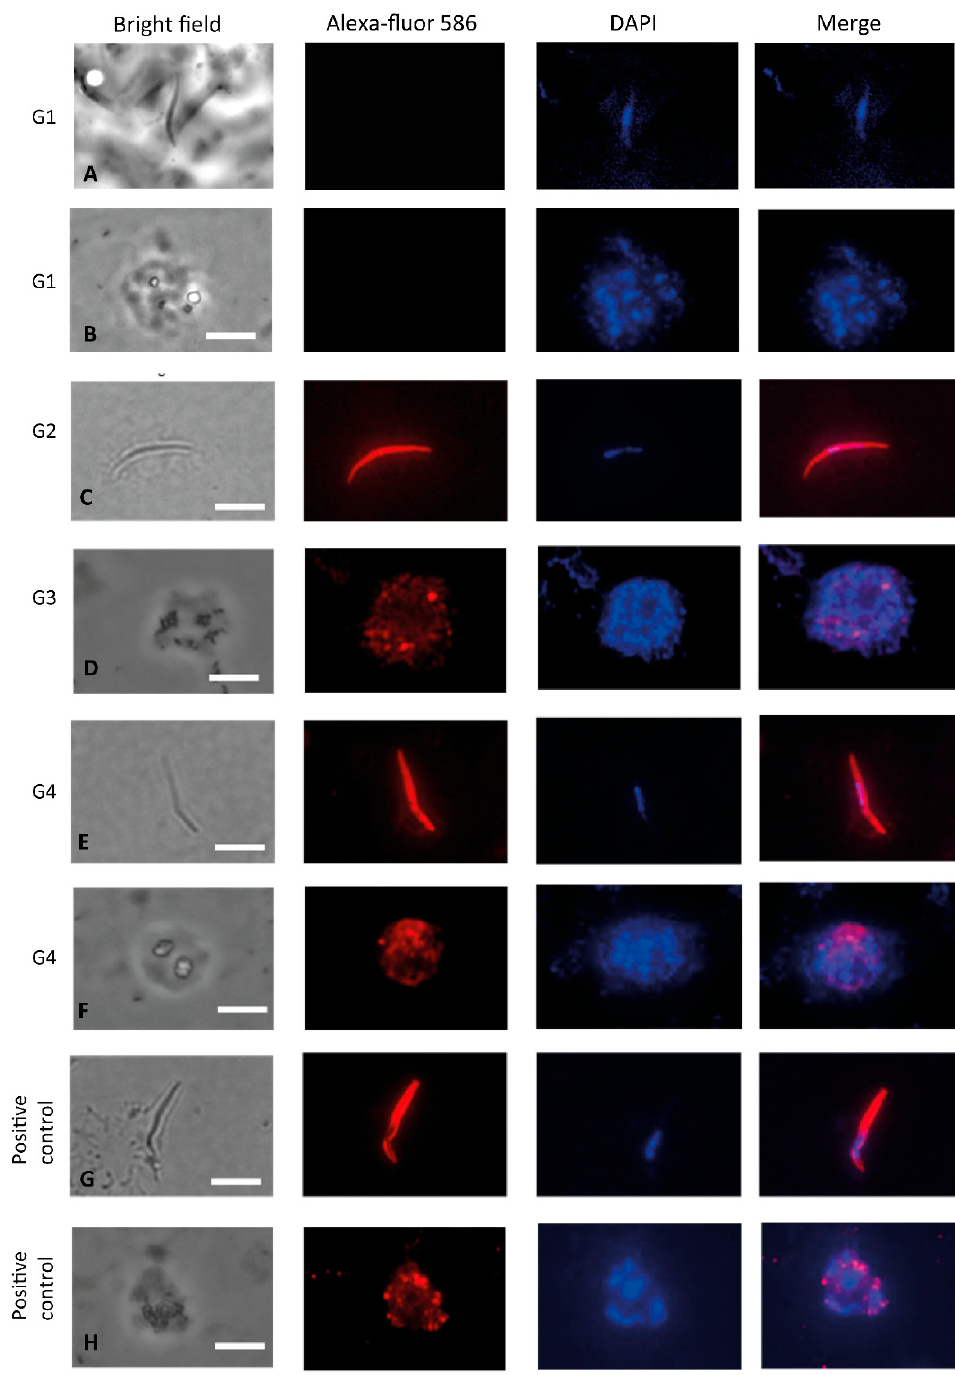
Figure 6. Indirect immunofluorescence analysis using sera from C57BL/6 mice. Microscope slides containing fixed sporozoites of P. vivax obtained from patients from Thailand ( A,C,E,G ) and merozoites of P. vivax obtained from patients from Rondônia (Brazil) ( B,D,F,H ) were incubated with a pool of sera from mice immunized with PvCSP-All FL, PvAMA-1 or protein mixture in the presence of poly(I:C). ( A,B ) G1: negative control sera from PBS + poly(I:C), ( C ) G2: polyclonal sera anti-PvCSP-All FL (1:100), ( D ) G3: polyclonal sera anti-PvAMA-1 (1:100), ( E ) G4: polyclonal sera anti-Mix (1:100), ( F ) G4: polyclonal sera anti-Mix (1:100), ( G ) positive control mAb anti-CSP-VK210 (1:100), and ( H) positive control mAb K243 anti-PvAMA-1 (1:1000). The white bars are equivalent to 10 µ